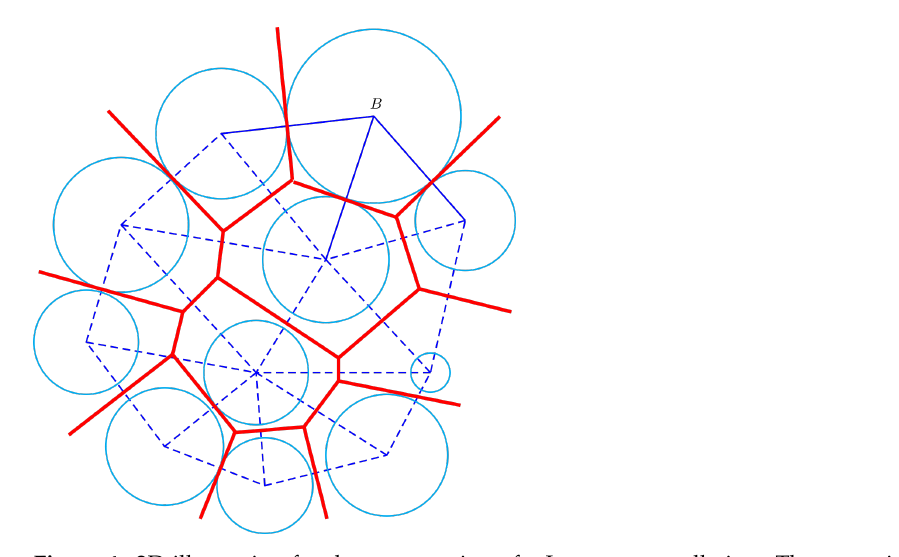
Figure 4. 2D illustration for the construction of a Laguerre tessellation. The cyan circles are the generators with their weights, the red solid lines are the resulting faces of the Laguerre